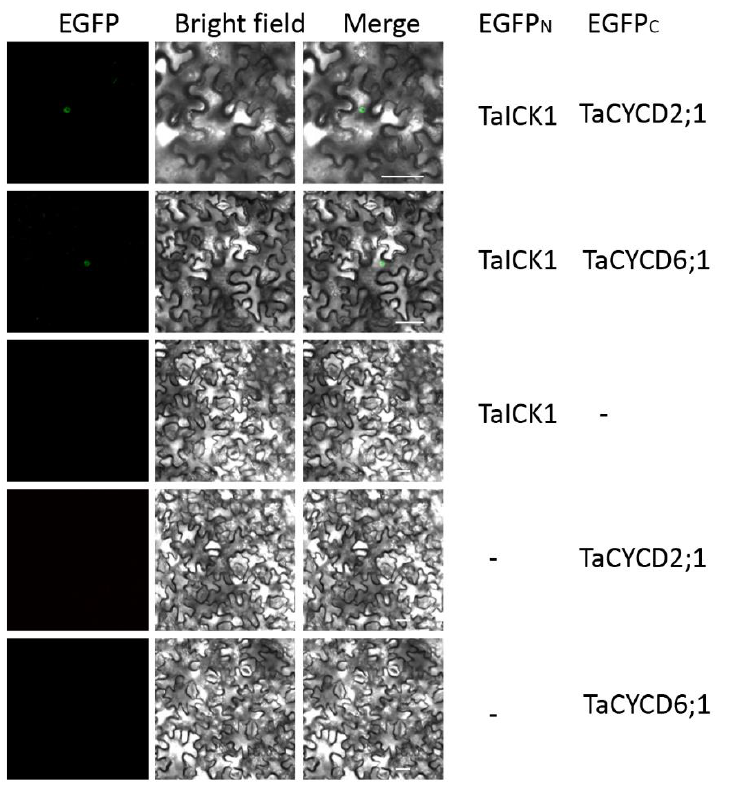
Figure 9. The interaction of TaICK1 with CYCD2;1 and CYCD6;1 in the BiFC system. Fluorescence (EGFP), bright field, and merged images were obtained using a confocal microscope. The scale bars are 50 µm.